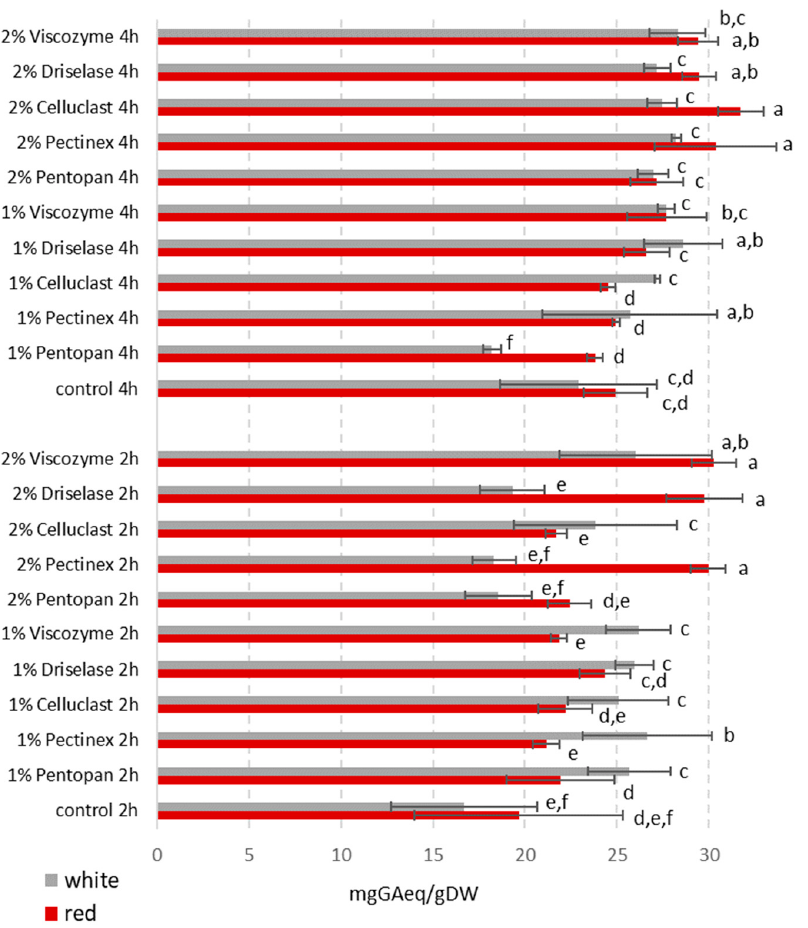
Figure 1. Total phenolic compound contents in white (Garganega) and red (Merlot) grape pomace enzymatic extracts obtained after treatment with five different commercial enzymes at 1% or 2% enzyme/substrate ratios ( w/w ), for 2 h or 4 h. Control samples were subjected to the same treatment conditions without any enzyme. Results are expressed as mg of gallic acid (GA) equivalent per gram of pomace dry weight (DW). Data represent the mean ± SD ( n = 3). Different letters indicate a statistically significant difference (one-way ANOVA test followed by post-hoc corrected two-tailed Tukey test, p < 0.05), from the highest (a) to the lowest (f). Table 1. Regression coefficients estimated for the DoE models. Stars indicate the significance level